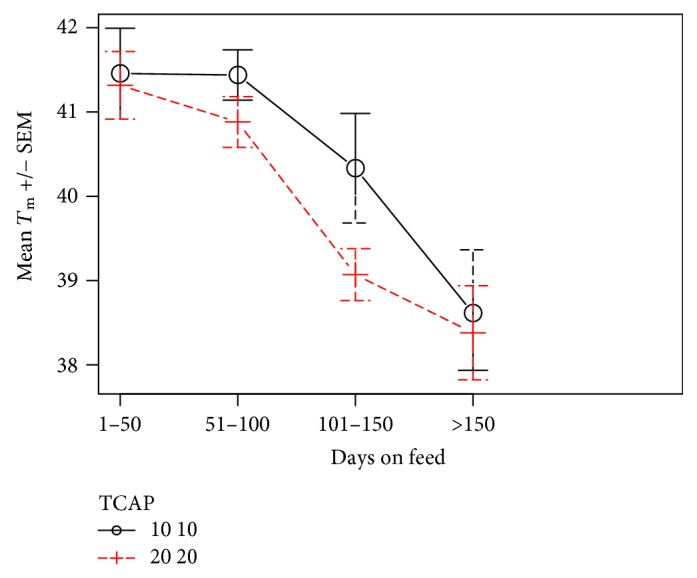
TCAP 20 animals have significantly lower Tm for 50–150 days on feed. The presence of homozygous 20 TCAP alleles makes the decrease in Tm occur at less days on feed. The initial Tm is similar between the two groups. The Tm in both groups appears to reach a minimum level with long feeding that is not affected by the TCAP allele.